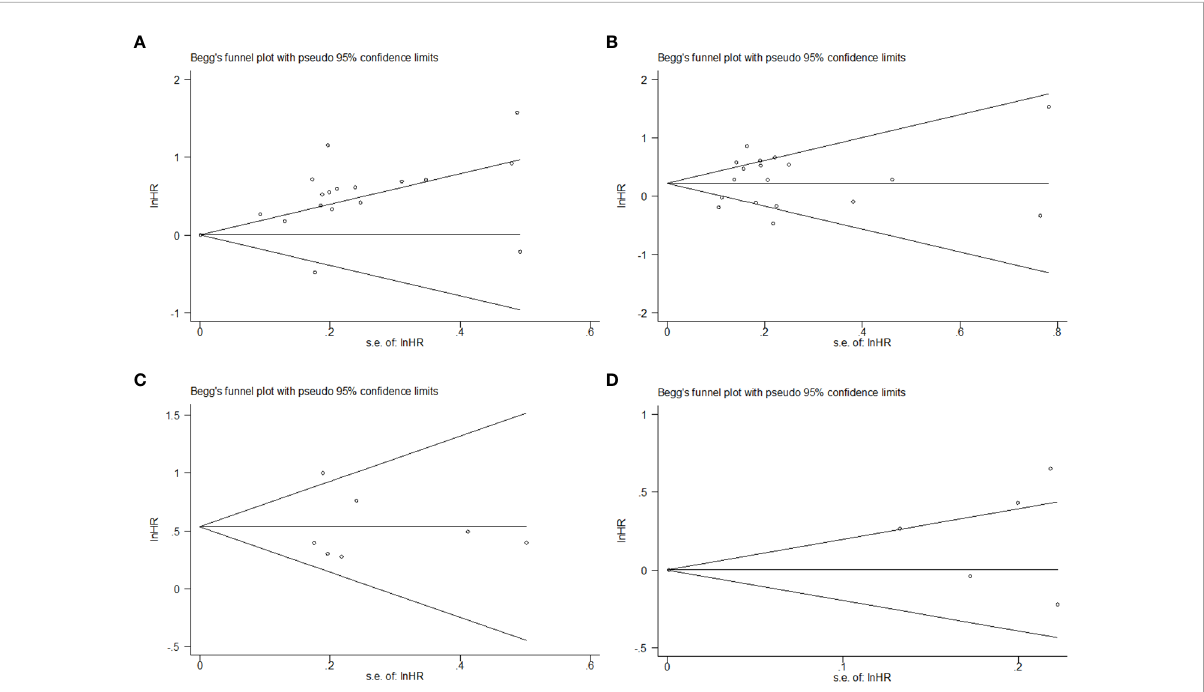
FIGURE 5 Begg ’ s funnel plot of HR on prognosis in SCLC patients with different levels of PLR. (A) HR on OS in the univariate model; (B) HR on OS in the multivariate model; (C) HR on PFS in the univariate model; (D) HR on PFS in the multivariate